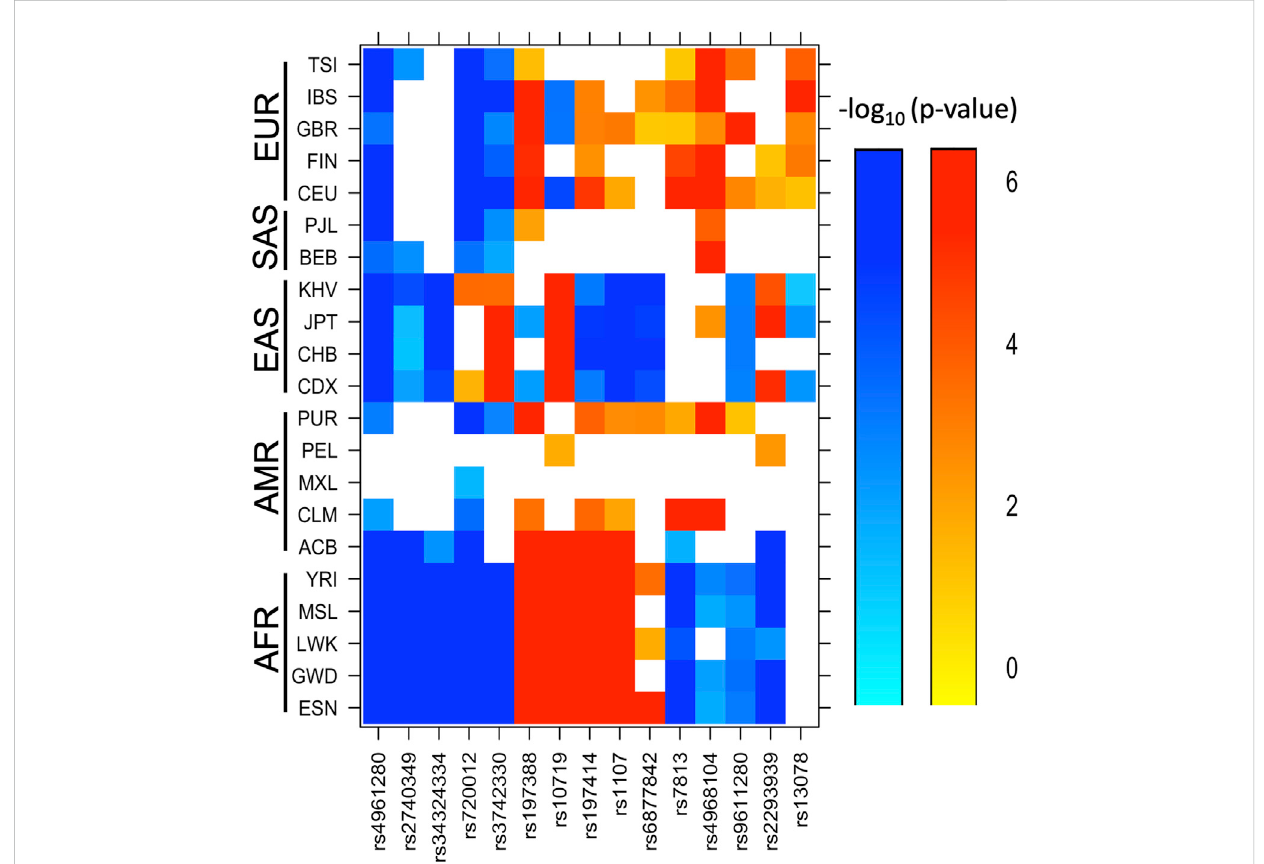
FIGURE 1 Ethnicgroupswithsigni fi cantdifferencesintheminorallelefrequenciesofSNVswithrespecttoMexicanindividuals.Theminorallelefrequenciesof the15 SNVs found in the Mexican mestizo population (MEZ) in this study were compared against those reported in 21 sub-continental populations from the 1,000 Genomes database. The color gradient from light blue to dark blue indicates increasingly lower frequencies compared to MEZ ( – log p-value range = 0 – 6). The color gradient from yellow to red indicates increasingly higher frequencies compared to MEZ ( – log p-value range = 0 – 6). Abbreviations are ACB: African Caribbean in Barbados; BEB: Bengali in Bangladesh; CDX Chinese Dai in Xishuangbanna, China; CEU: Utah residents with Northern and Western European ancestry; CHB: Han Chinese in Beijing, China; CLM: Colombian in Medellin, Colombia; ESN: Esan in Nigeria; FIN: Finnish in Finland; GBR: British in England and